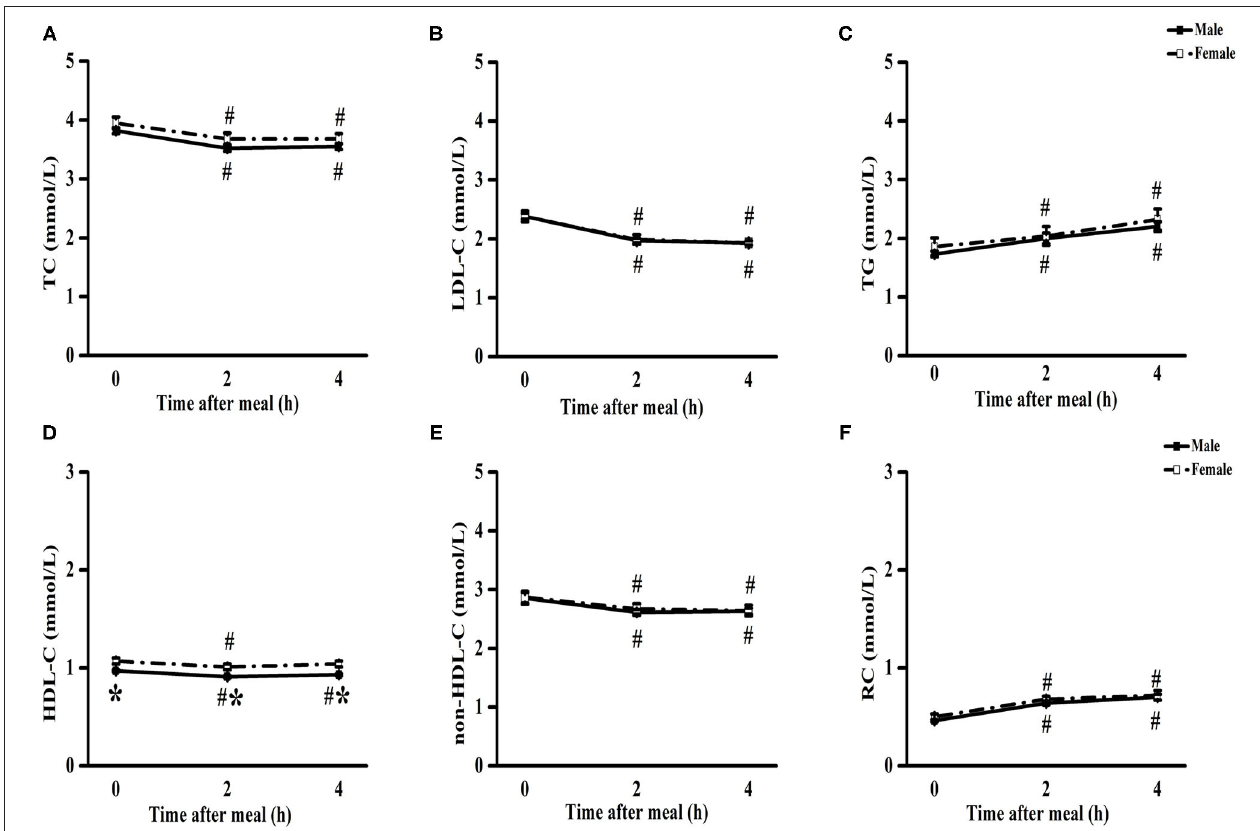
FIGURE 1 | Comparisons of blood lipids in patients with CHD between male and female after a daily breakfast. Comparisons of TC (A) , LDL-C (B) , TG (C) , HDL-C (D) , non-HDL-C (E) and RC (F) levels between male and female patients with CHD. # P < 0.05 when compared with fasting value within the same group, * P < 0.05 when compared with those of female patients at the same time